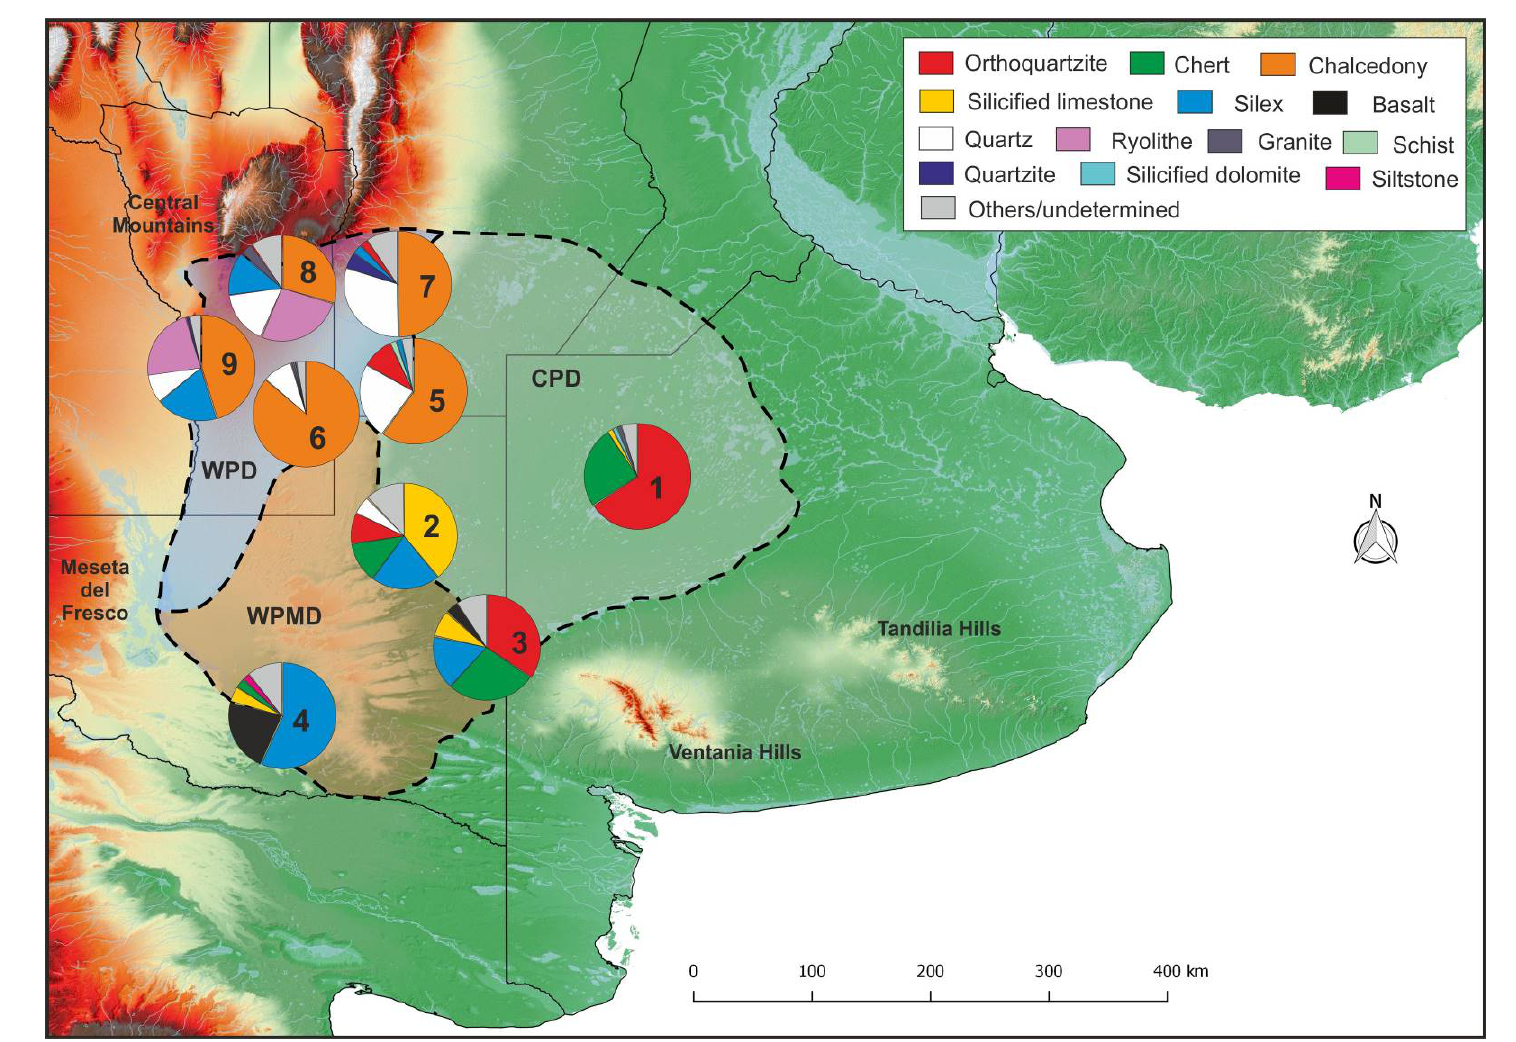
Figure 3. Frequency of the main lithic raw materials by areas. Numbers are associated with the areas: 1- CPD from the Pampa grasslands; 2- Center-east of the dry Pampas; 3- Transverse valleys; 4- Salado-Curacó rivers and western dry Pampas; 5- Eastern Pampa of the dry Pampas; 6- Xerophytic woodland and high structural; 7- Quinto River; 8- Wet crossing; 9- Dry